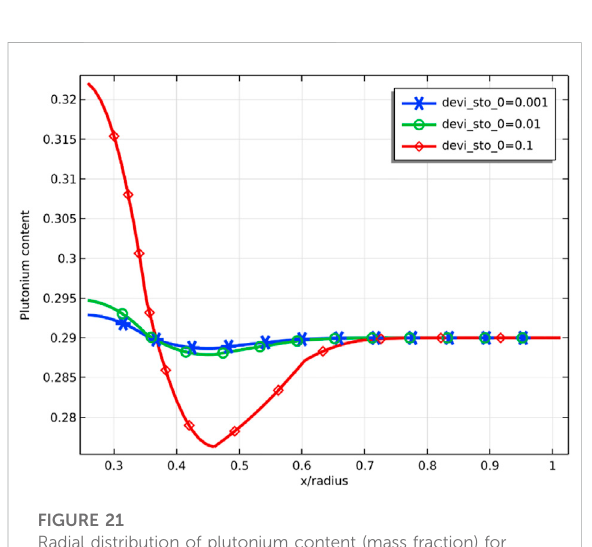
FIGURE 21 Radial distribution of plutonium content (mass fraction) for deviationfromthestoichiometryofoxygensof0.001,0.01,and0.1 (fuel burnup of 8 at%).